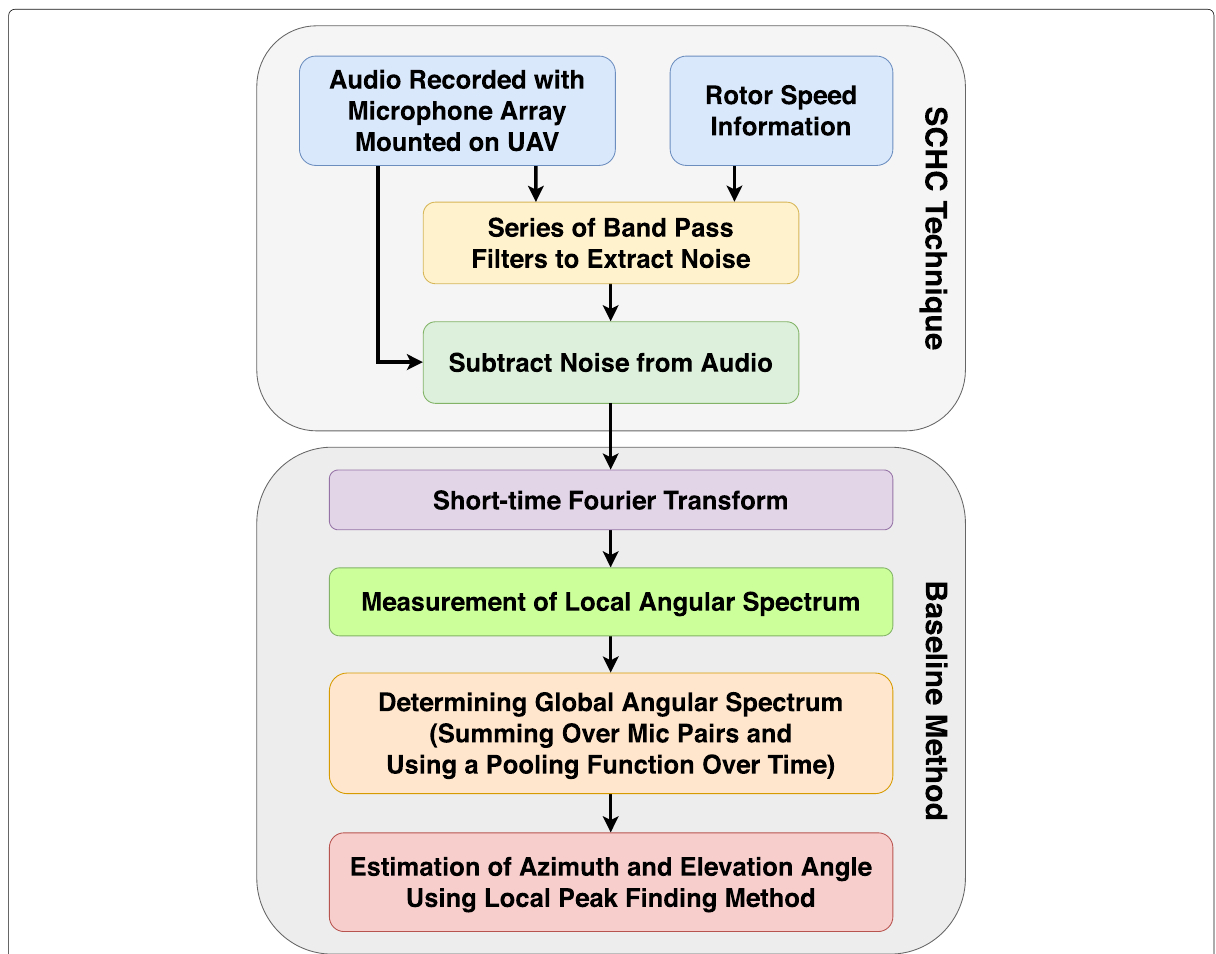
Fig. 4 Block diagram of the modified baseline